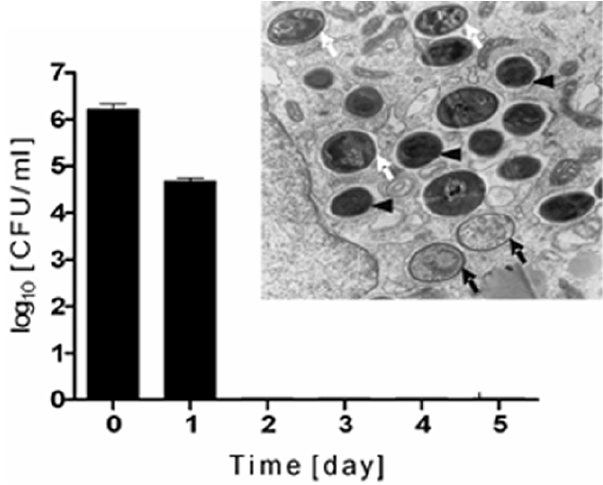
Figure 7. An a -hemolysin mutant of S. aureus strain Newman is efficiently killed in phago(lyso)somes within two days of phagocy- tosis. Intracellular persistence of S. aureus was determined as described in the legend of Fig. 3A. Bars represent mean CFU values 6 SD and are representative of at least three separate experiments, performed in triplicate, using hMDMs derived from different donors. An electron microphotograph of infected hMDMs was obtained 1 day post- phagocytosis and shows partially (white arrows) and totally degraded (black arrows) bacterial cells inside tight vacuoles. At this time point some apparently intact bacterial cells are also present (black arrowheads). Magnification: x32,500. The photograph presented is a representative of a minimum of 20 fields